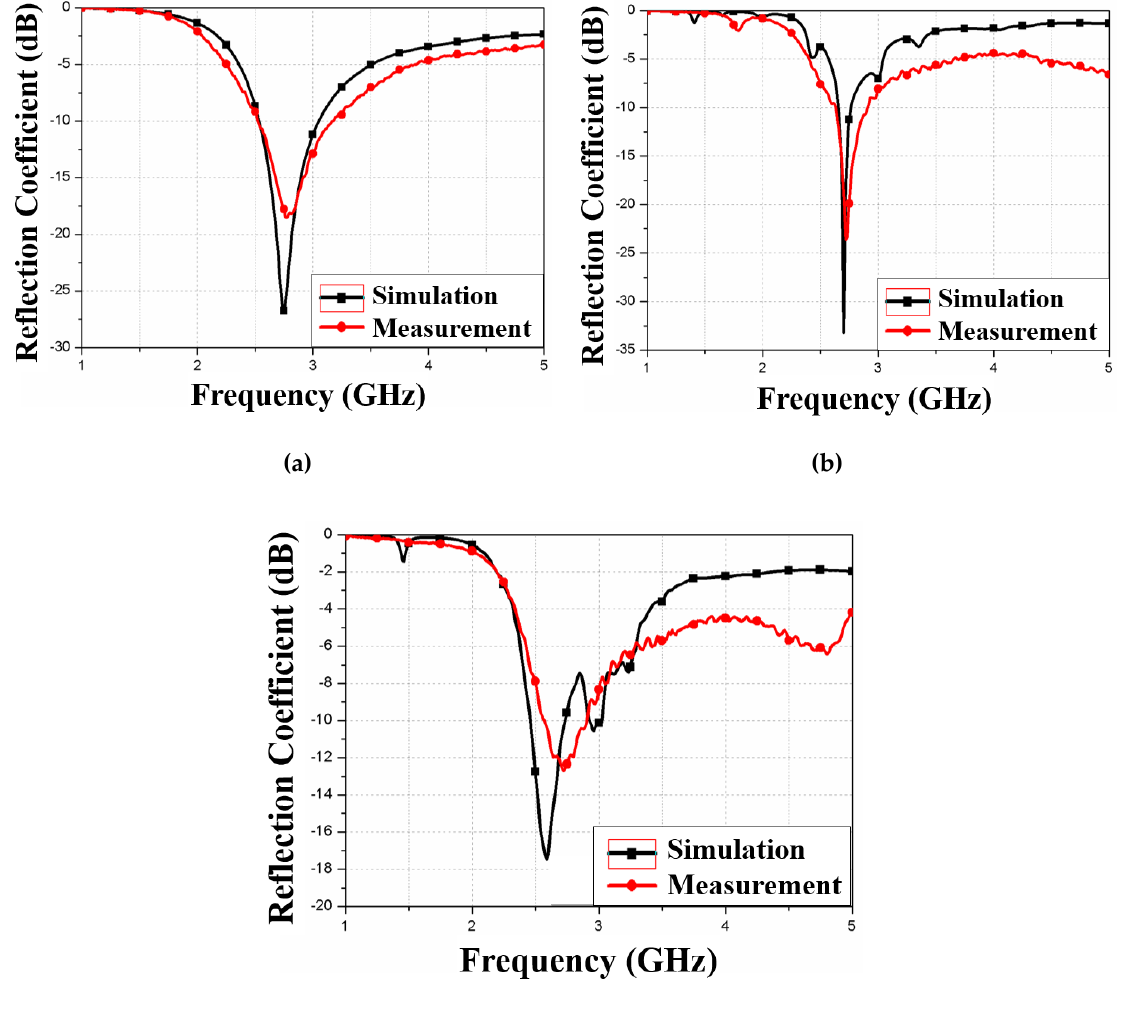
Figure 11. Simulated and measured reflection coefficients for ( a ) reference antenna 1, ( b ) reference antenna 2, and ( c ) proposed antenna.